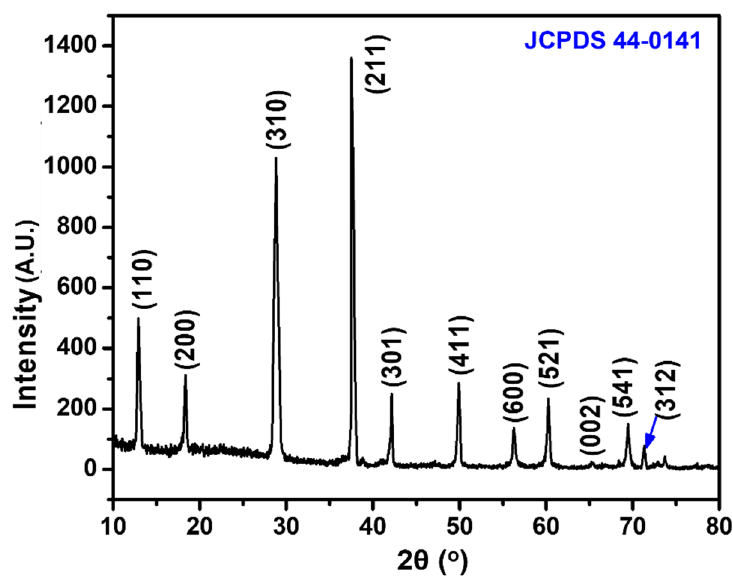
Figure 1. XRD diffraction pattern of α -MnO 2 nanowires.